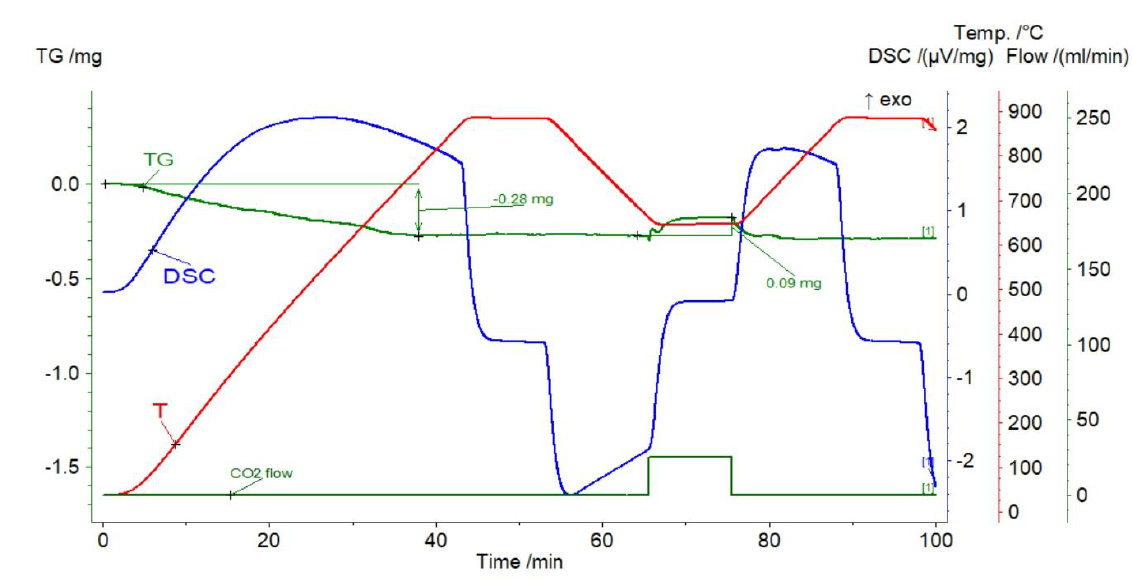
Figure 10. TGA and DSC curves for nephelinite.